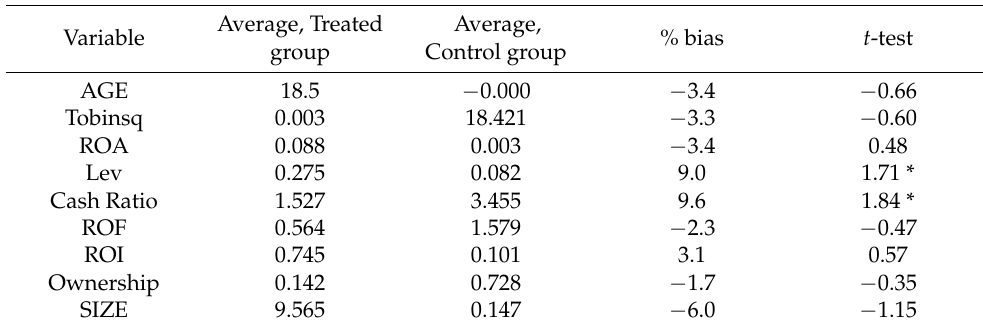
Panel B: Test of the effectiveness of the propensity score